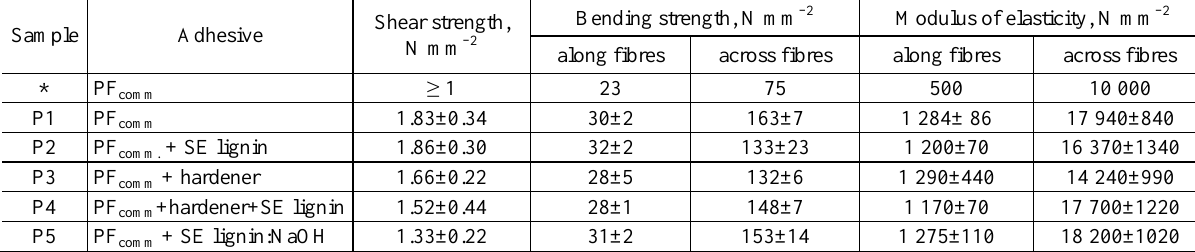
Fig. 9. Plywood specimens after shear strength test. Dark brown square – apparent cohesive wood failure Table 7. Shear strength and elasticity of plywood samples. * Requirements of Joint Stock Company “ Latvijas Finieris